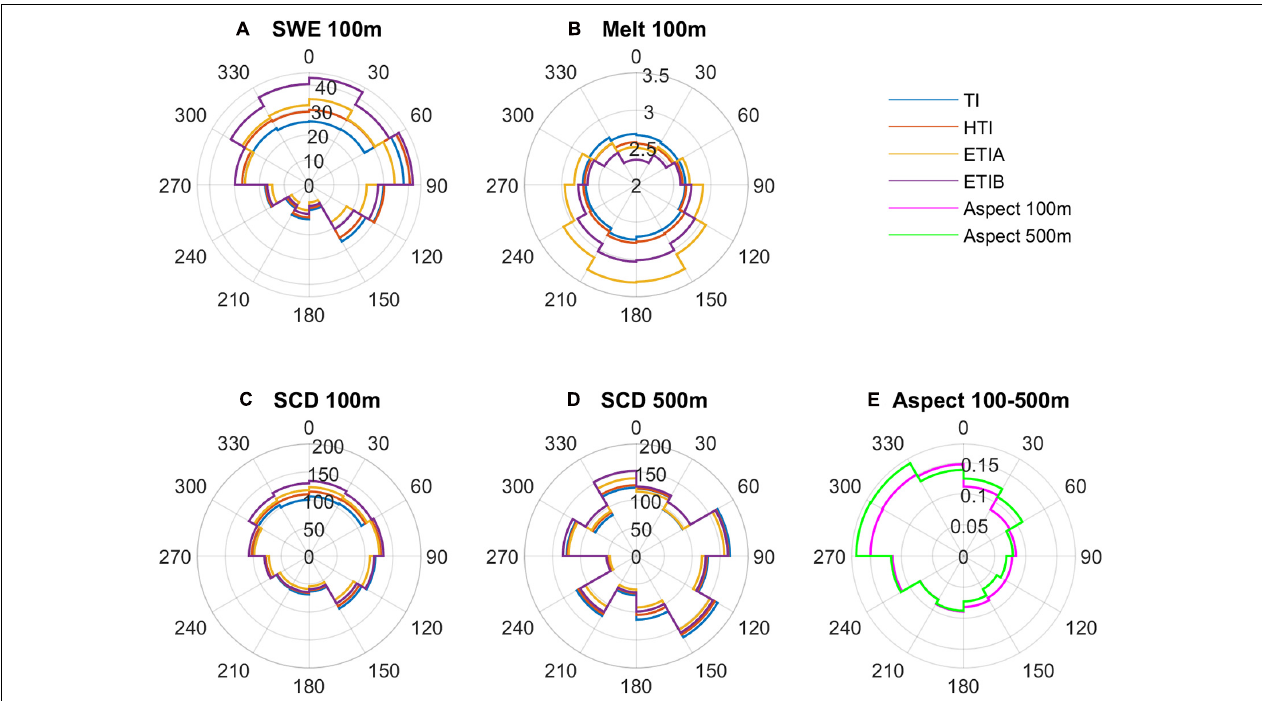
FIGURE 10 | Mean simulated SWE, melt rate, and snow cover duration (SCD) by aspect. (A) Mean SWE (mm). (B) Melt rate (mm d − 1 ). (C) SCD (days) at 100 m resolution. (D) SCD (days) at 500 m resolution. (E) DEM aspect at 100 and 500 m